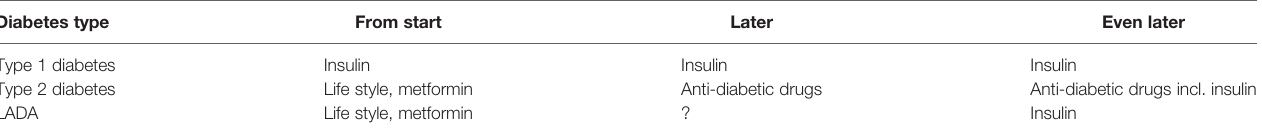
TABLE 1 | Consensus regarding how to treat